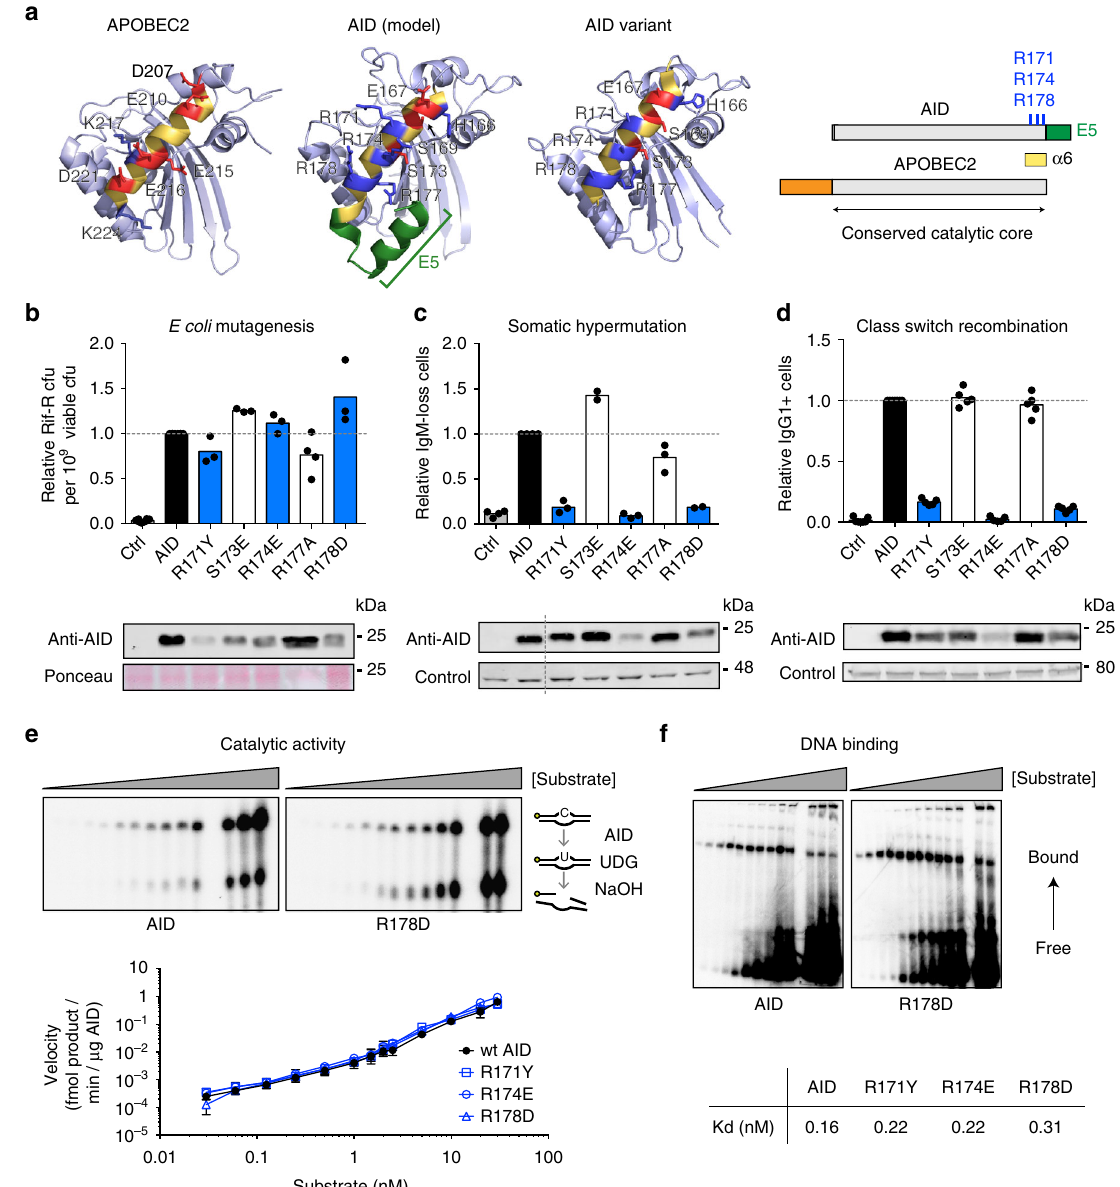
Fig. 1 Identi fi cation of functionally inactive AID variants. a (Left) Comparison of our 3D model of AID to the experimental structure of APOBEC2 (PDB 2NYT) and an AID variant (PDB 5JJ4) in the same orientation. Selected residues within helix α 6 are labelled. Side chains for basic (blue) and acidic (red) residues are shown. (Right) Schemes of AID and APOBEC2. b Mutagenic activity in E. coli , measured by the relative frequency of rifampicin-resistant (Rif- R) colony-forming units (cfu) arising from cultures expressing AID variants or empty vector (Ctrl). Means (bars) of median values (dots) obtained from 3 to 8 independent experiments (5 cultures/experiment) per construct are shown, normalized to AID. c Somatic hypermutation activity, assayed by the relative IgM-loss accumulation in cultures of DT40 Aicda − / − ΔΨ V λ B cells complemented with AID variants-ires-GFP or empty vector (Ctrl). Means (bars) of the median values (dots) obtained from 2 to 5 independent experiments (12 – 24 cultures/experiment), each normalized to the median value of AID. d Class switch recombination activity in Aicda − / − mouse primary B cells cultured with LPS and IL-4 and transduced with AID variants-ires-GFP or empty vector (Ctrl). Means (bars) proportion of IgG1 + cells in the GFP + population at 72 h after transduction for each mouse (dots) from 5 to 7 independent experiments are shown, normalized to AID. In b – d , WB of cell extracts probed with anti-AID antibody and loading control are shown at the bottom. e Catalytic kinetics of puri fi ed recombinant wt AID and R-mutants assayed by the standard alkaline cleavage assay for deamination. (Top) Representative assays used to measure speci fi c activity of wt AID and R-mutants. (Bottom) Mean ± s.d. of four independent experiments were quanti fi ed. f DNA-binding af fi nity of wt AID and the R-mutants assayed by EMSA. (Top) Representative EMSA gels are shown. (Bottom) Mean Kd was calculated from four independent experiments for each AID variant. For gel source data, see supplementary Fig. AID, the R-mutants were cytoplasmic in steady state and accu- (WB) in cytoplasmic and nuclear extracts from untreated cells mulated in the nucleus after inhibiting nuclear export with lep- showed that nuclear levels for all AID variants were similar to wt tomycin B (LMB) and/or AID cytoplasmic retention with AID, even for R174E that showed reduced cytoplasmic levels didemnin B (Did B) (Fig. 2a). Probing for AID by western blot compared to wt AID (Fig. 2b). AID can be trapped inside the